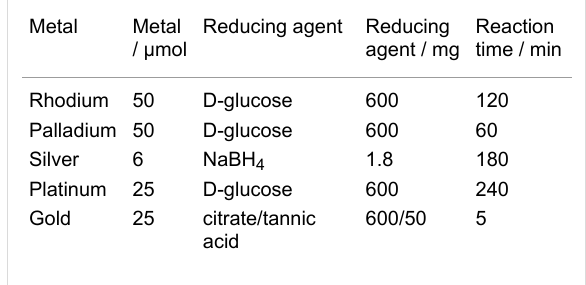
Table 1: Synthesis